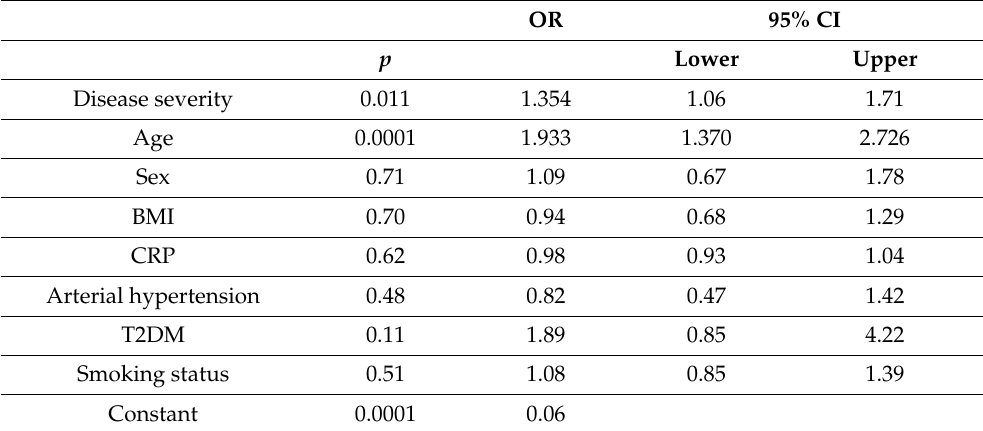
Table 6. Logistic regression analysis considering FMD as the dependent variable and disease severity